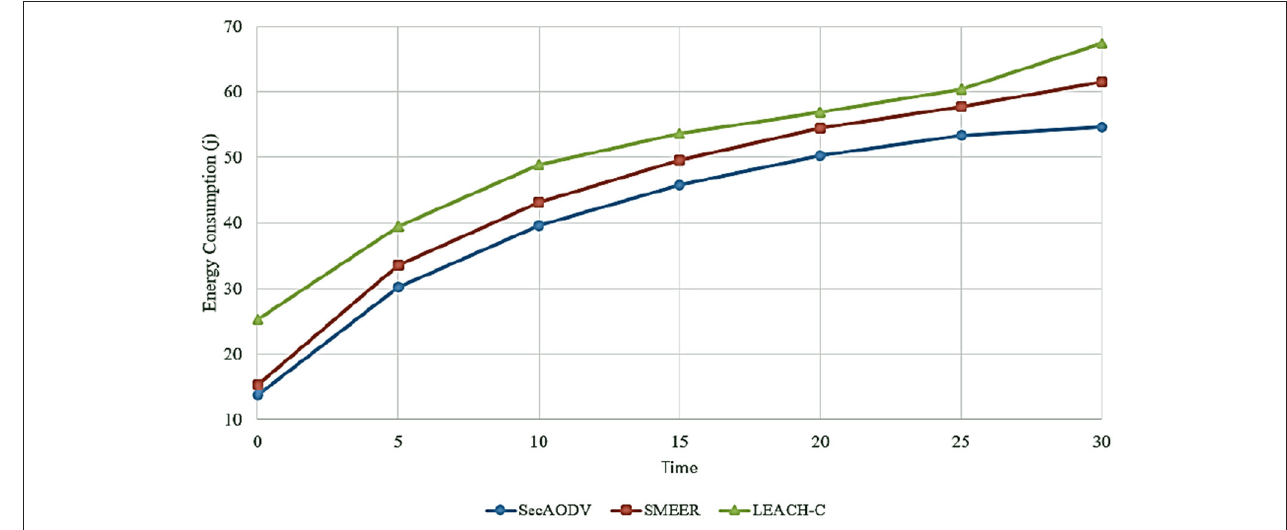
FIGURE 9 | Comparison of different methods in terms of energy